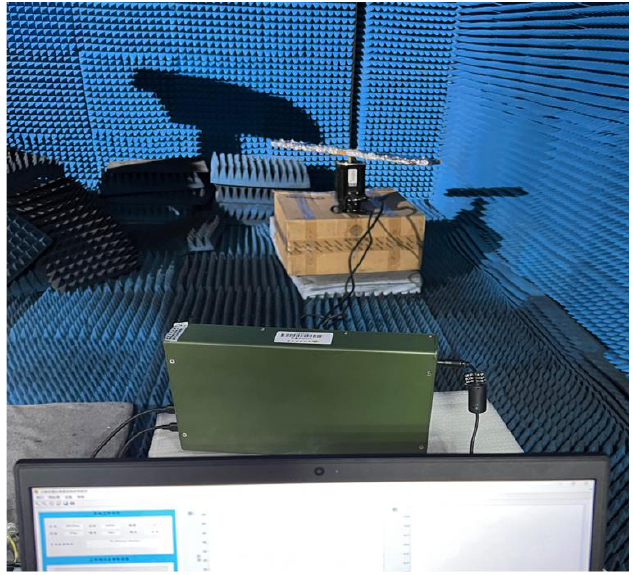
Figure 9. The scene of the micro-motion simulation experiment. Table 2. Table of parameters of the helicopter rotor micro-motion experiment.